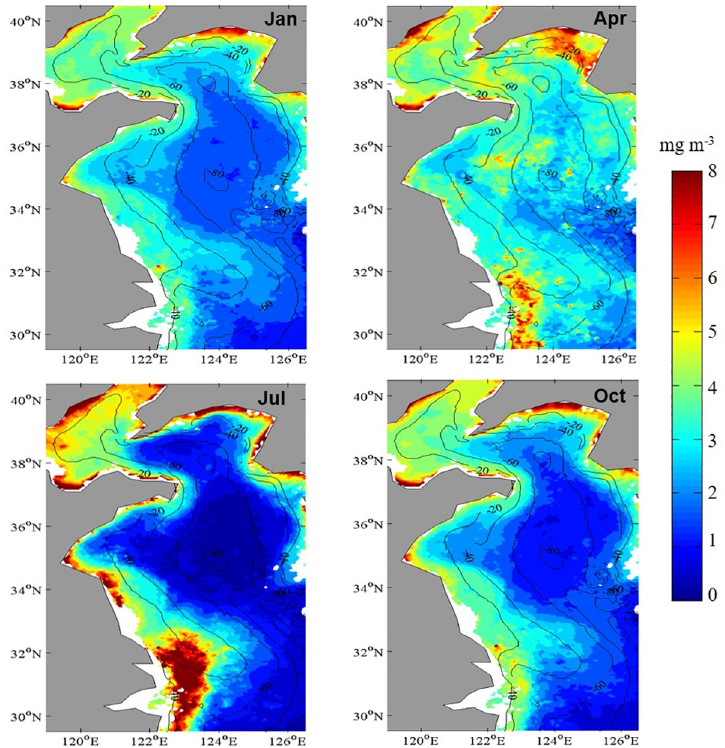
Fig 3. Monthly mean distributions of Chl- a during 2003–2015 in the Yellow Sea,